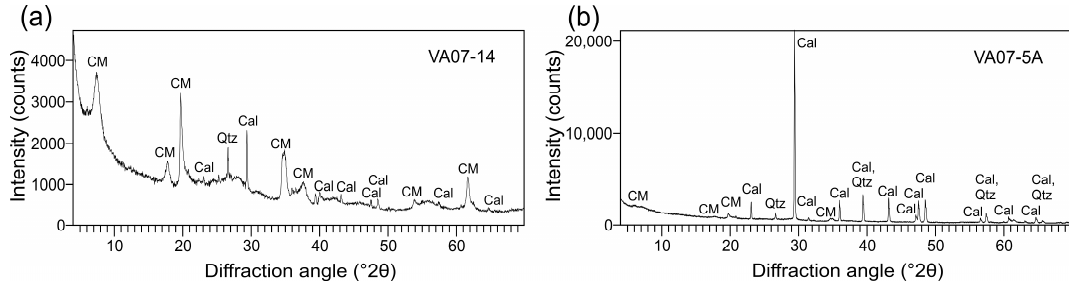
Figure 6. X-ray powder diffraction patterns of two representative samples from Vajont: ( a ) clay-rich sample VA07-14 and ( b ) calcite-rich sample VA07-5A.